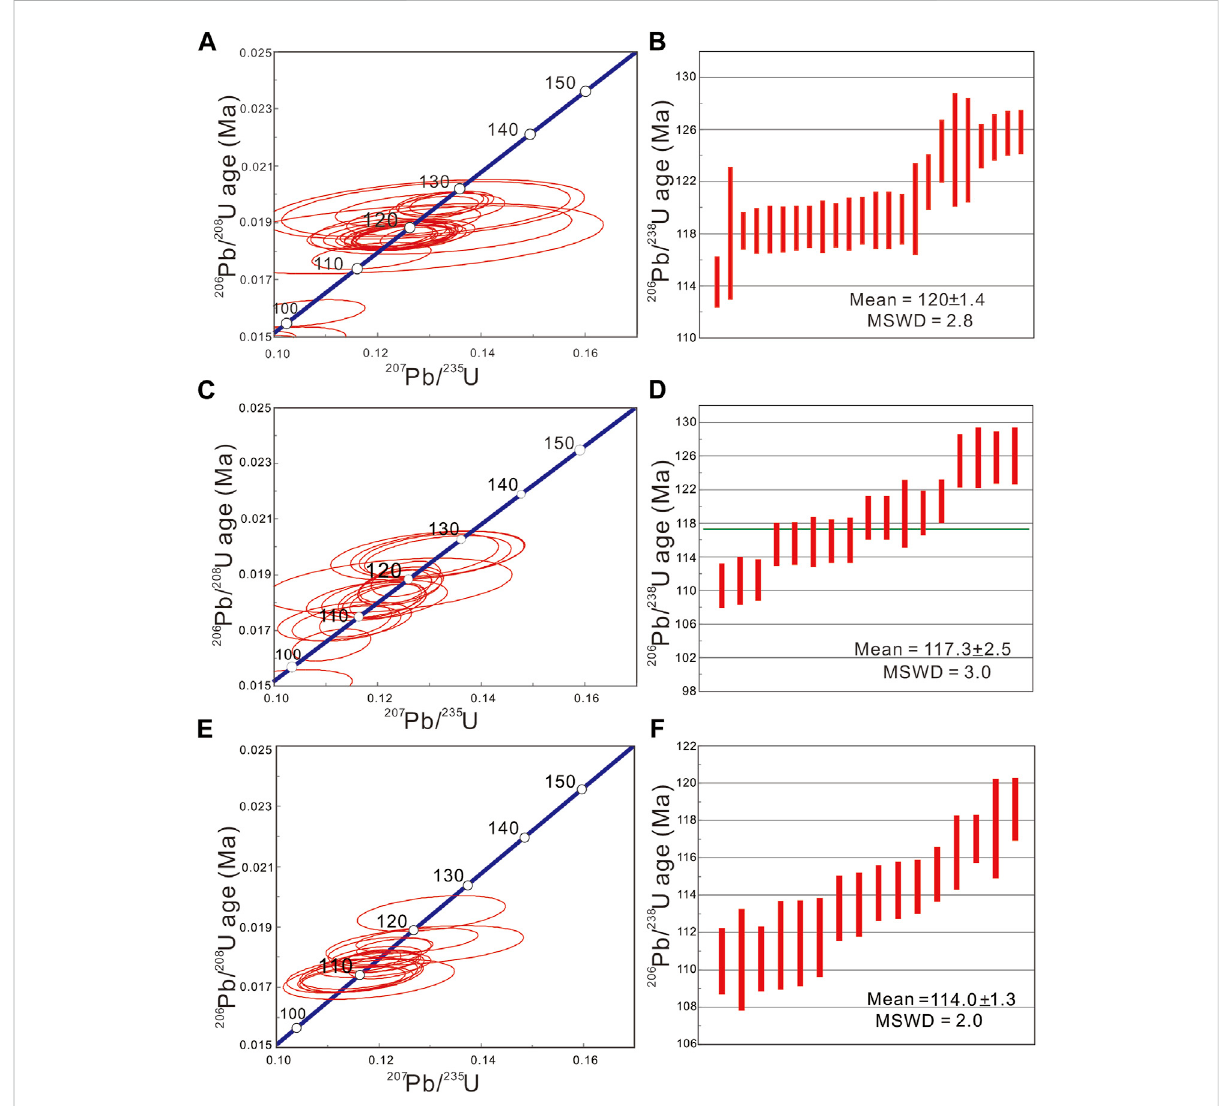
FIGURE 6 LA-ICP-MS zircon U-Pb Concordia diagrams for the granitic pluton.